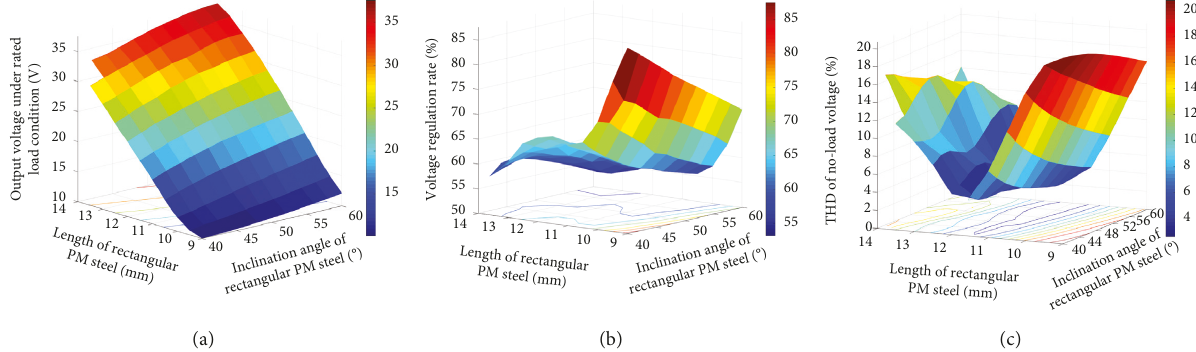
Figure 18: Variation diagrams of generator output performance with different inclination angles and lengths of rectangular PM steel: (a) output voltage under rated load condition; (b) voltage regulation rate; (c) THD of no-load voltage.